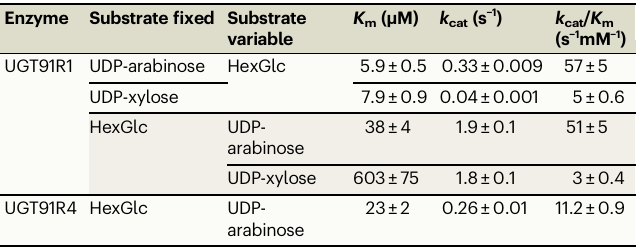
Table 2 | Kinetic parameters of UGT91R1 and UGT91R4 Enzyme Substrate fi xed Substrate